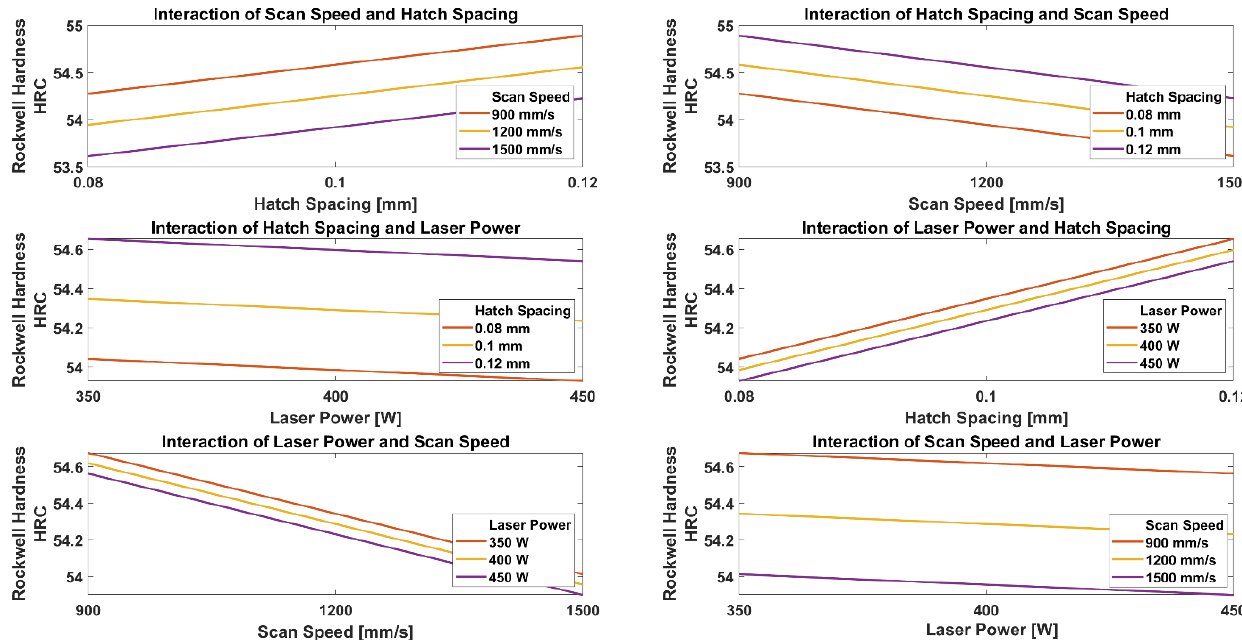
Figure 15. Effects of the interaction of parameters on the measured HRC on the top surface.